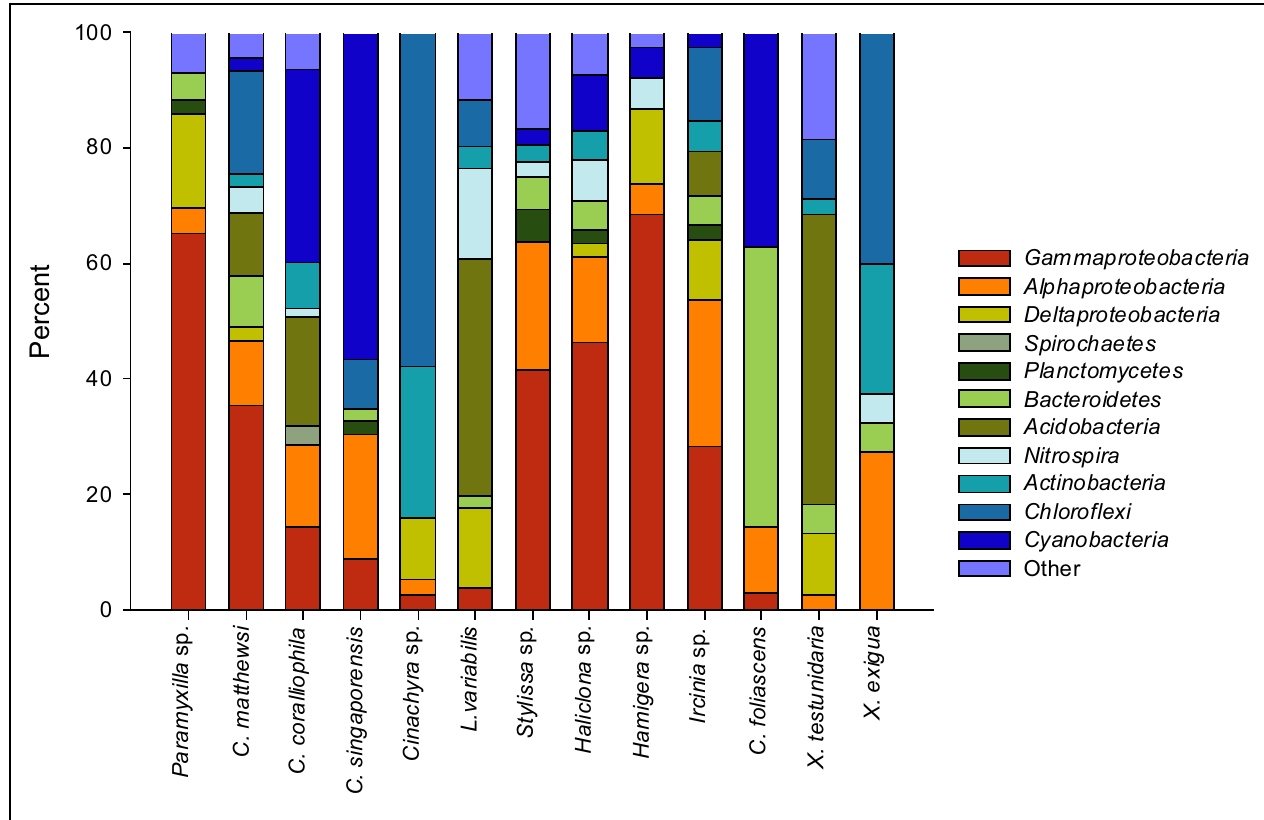
FIGURE 3 | Bar charts showing the relative abundance of each bacterial phyla (and class for the Proteobacteria ) within each host species.